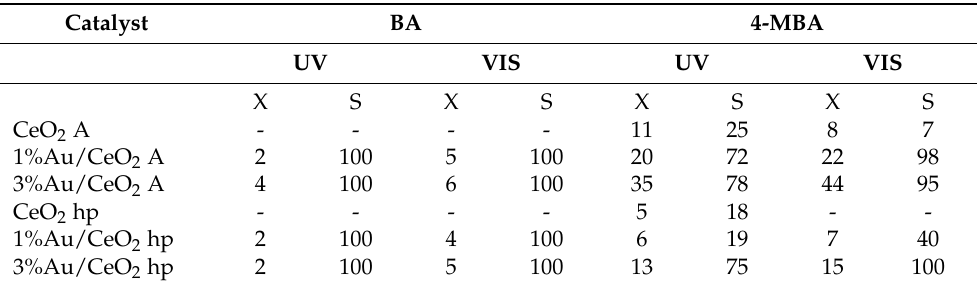
Table 3. Conversion percentage (X) of BA and 4-MBA and selectivity percentage (S) towards the corresponding aldehyde after 4 h of UV or visible (VIS)